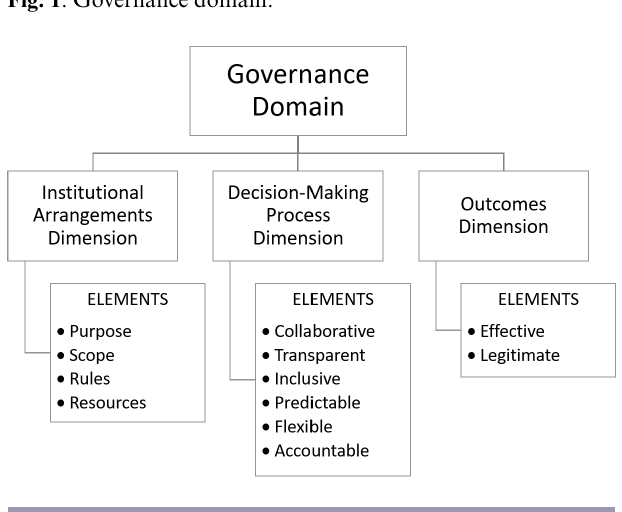
Fig. 1 . Governance